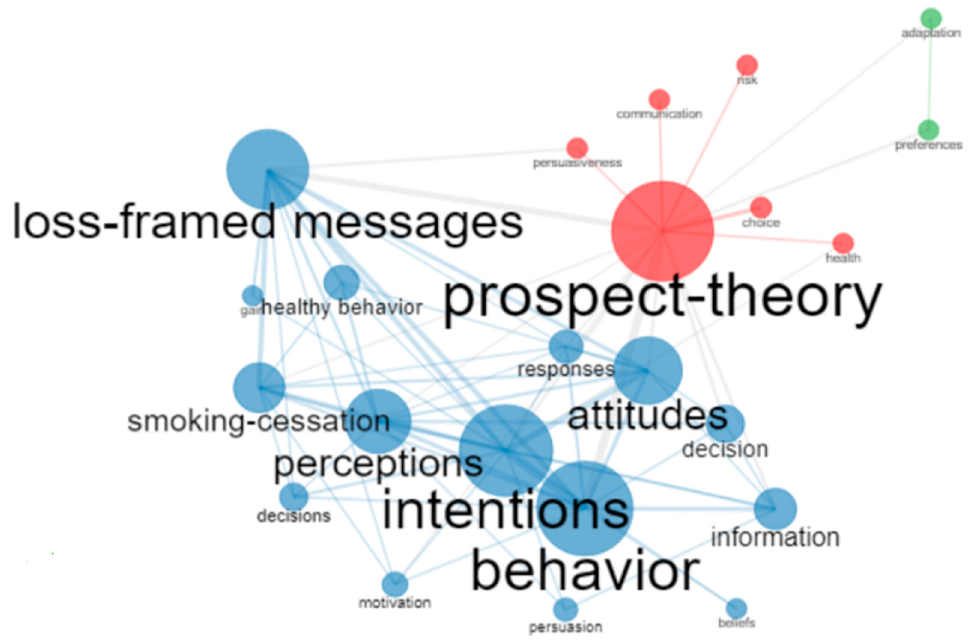
Figure 4. Co ‐ occurrence